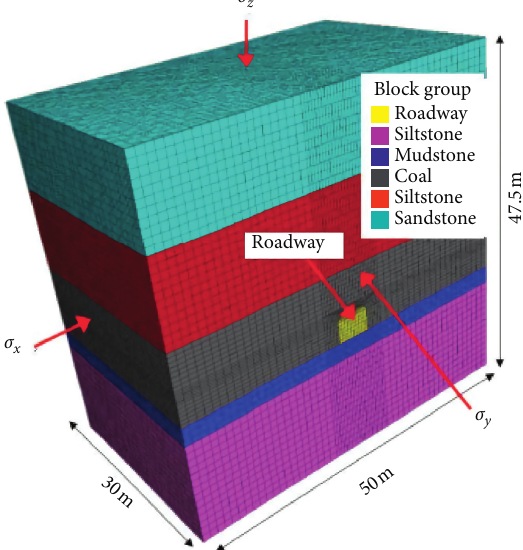
Figure 4: Three-dimensional numerical simulation model of the No. 3